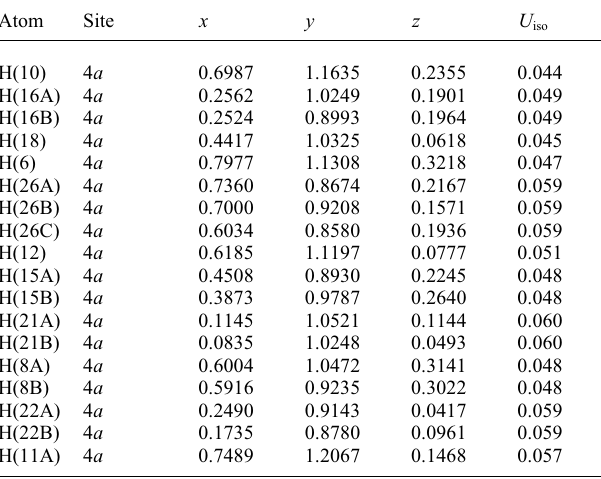
Table 2. Atomic coordinates and displacement parameters (in Å 2 )